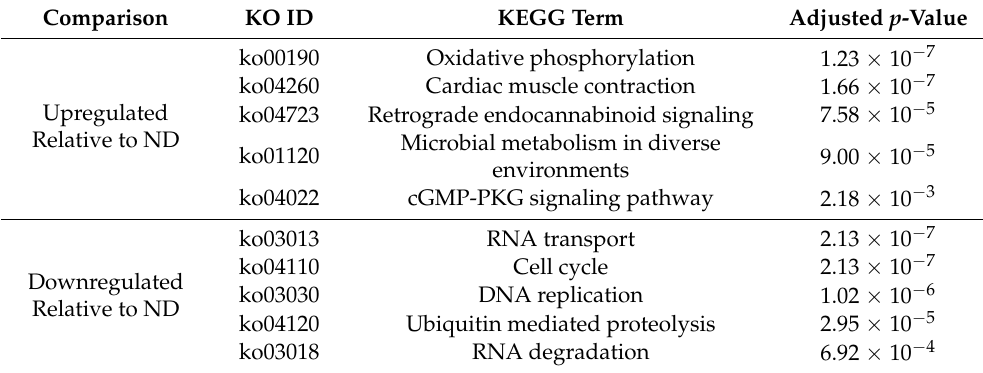
Table 3. Summary of the top five (when available) KEGG pathways involved in ED. The table shows KEGG pathways that were up- and downregulated relative to ED. Enriched KEGG pathways relative to ND were identified with the GAGE and Pathview packages in R. Terms were sorted by the Benjamini-Hochberg adjusted p -value. KEGG pathways differentially expressed relative to MD are shown in Table 5, and a complete list of up- and downregulated KEGG terms can be found in Supplementary Table